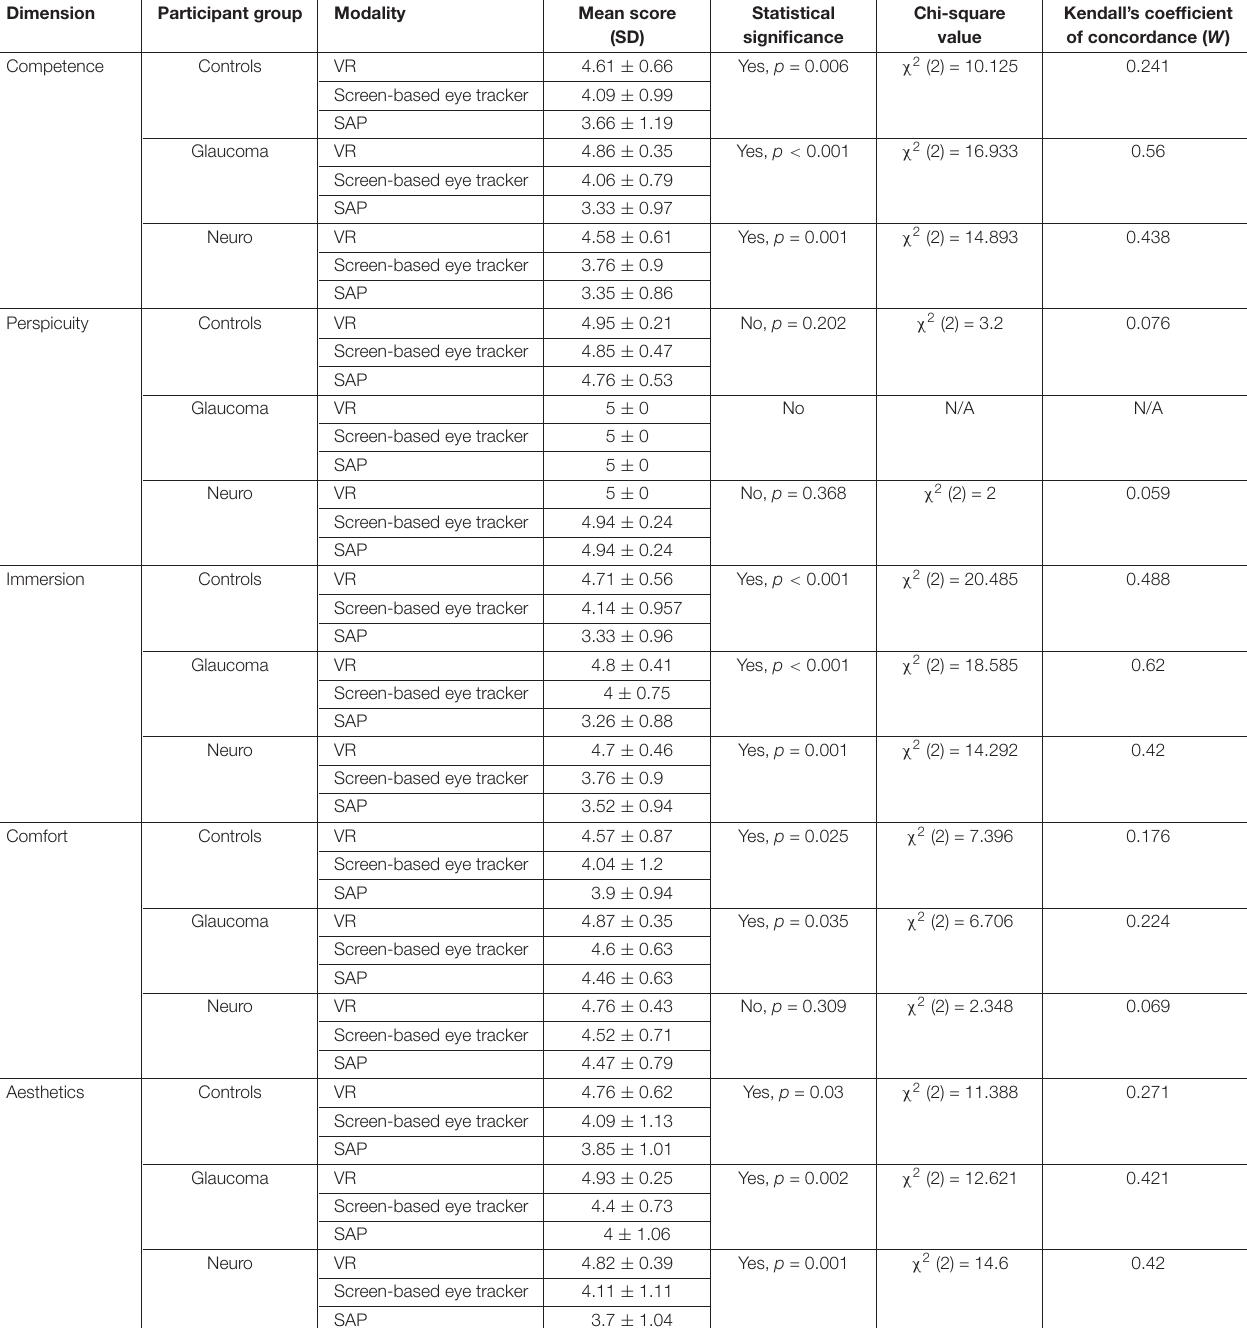
TABLE 5 | The mean scores, results of Friedman’s test and the corresponding effect sizes on the ratings provided by the participants in each clinical group for each modality and the first five dimensions of the UEQ.